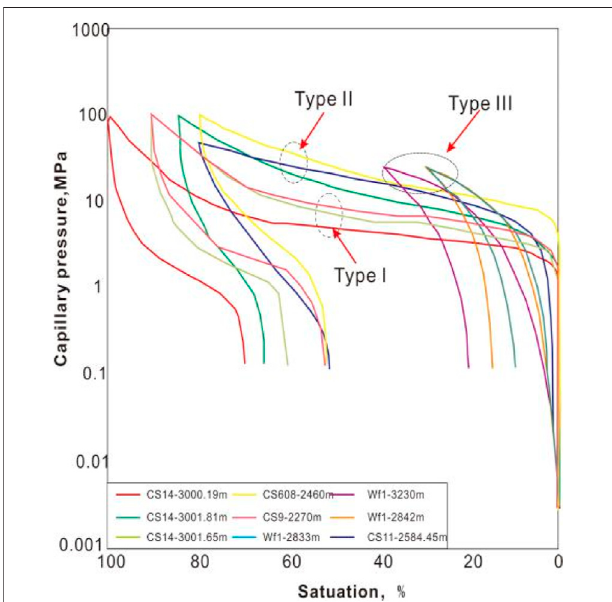
FIGURE 8 | Classi fi cation diagram of the mercury injection curve of the typical volcanic reservoir in the Wangfu gas fi eld.